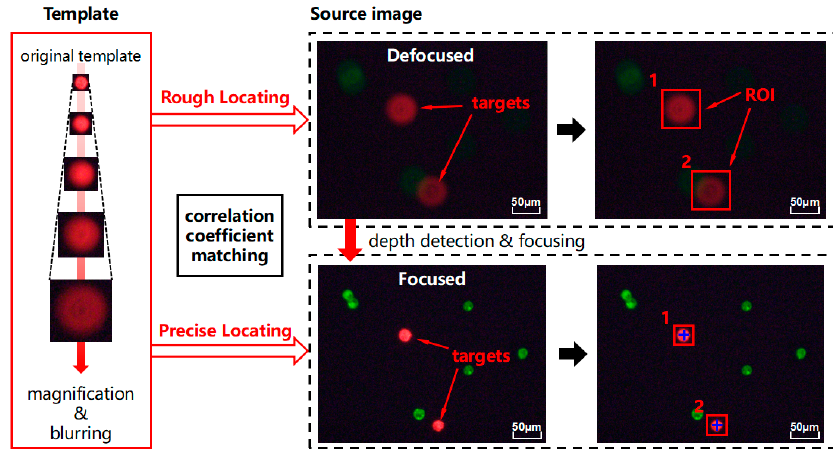
Figure 2. Schematic of scalable correlation coefficient matching.